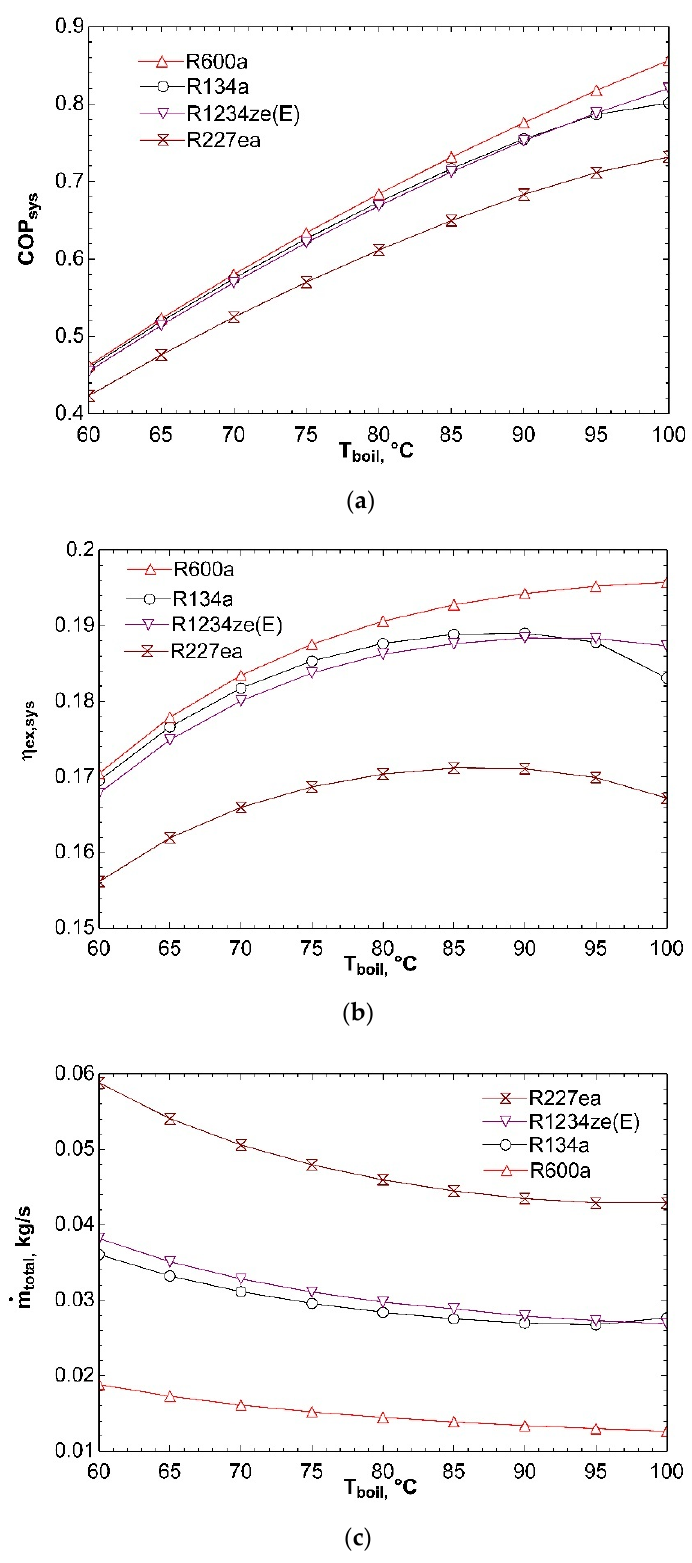
Figure 6. Effect of T boil on COP sys ( a ), ƞ ex,sys ( b ), and ṁ total ( c ) in combined ORC-single evaporator VCR Figure 6. E ff ect of T boil on COP sys ( a ), η ex,sys ( b ), and ˙m total ( c ) in combined ORC-single evaporator cycle. VCR